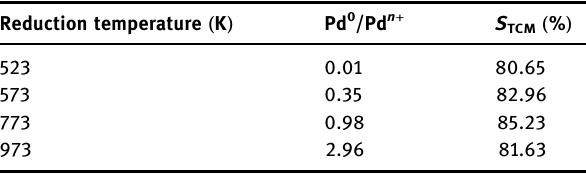
Table 3: E ff ect of the reduction temperature on the catalytic performance